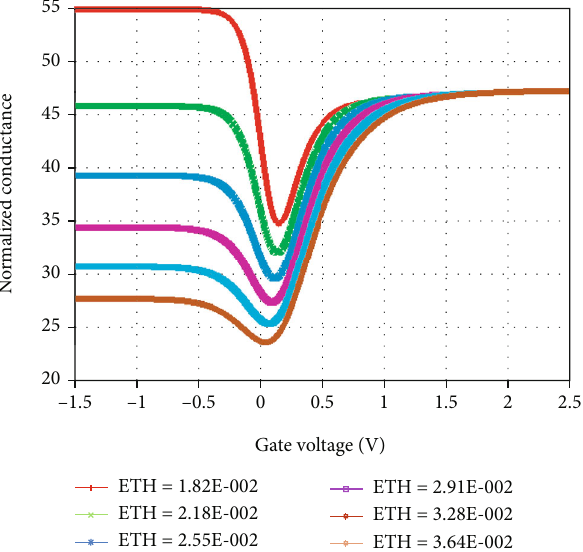
Figure 2: Blocking conditions. Normalized conductance versus gate voltage and a plotted graph of equation (5).